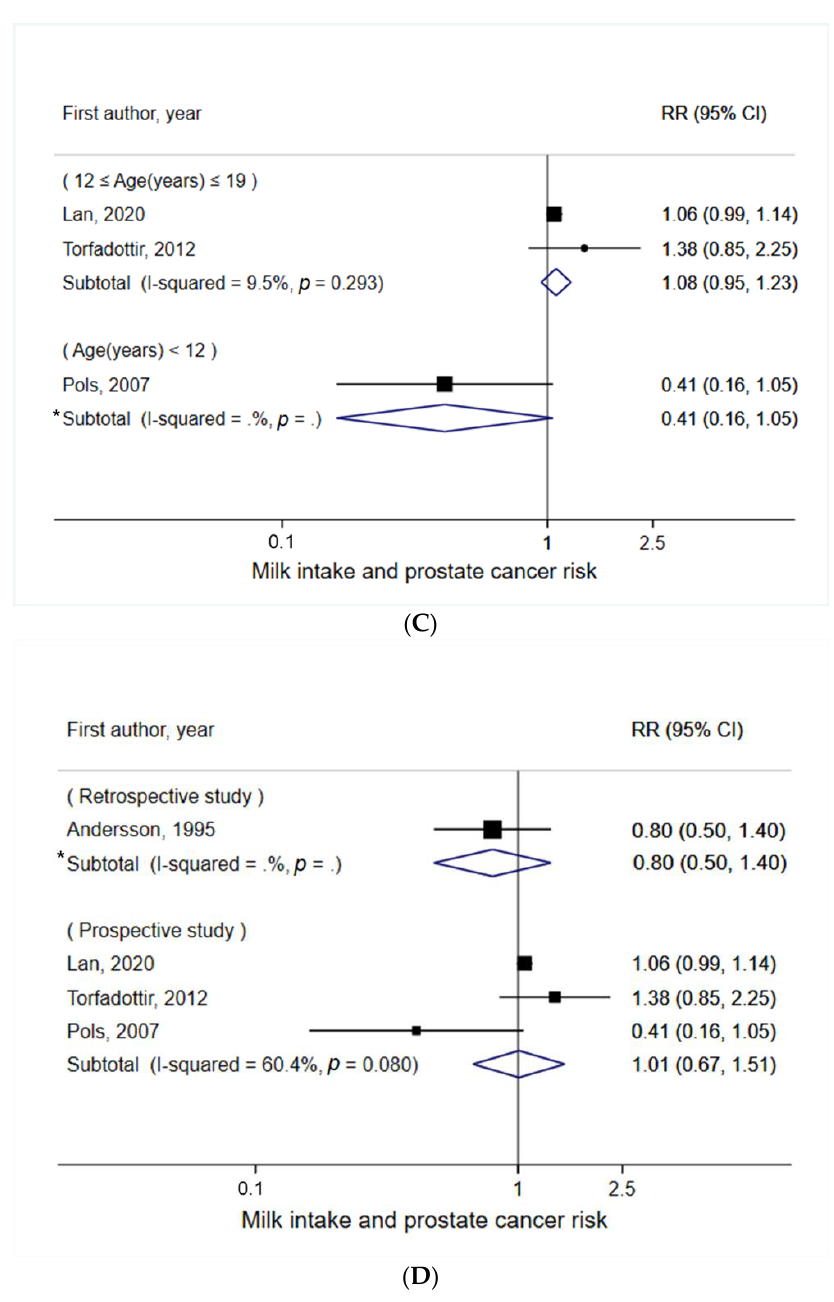
Figure 3. Meta-analysis of milk intake in early life ( A ) with any prostate cancer risk, ( B ) by cancer stage, ( C ) by life stage of milk intake, and ( D ) by study design. For each study, the RR and corre- sponding 95% CI of individual studies are marked by the location of the black box and the width of the horizontal line, respectively. The size of the box indicates the weight that the RR receives when calculating the summary estimate. The summary RR and its 95% CI are represented by the center and weight of the diamond, respectively. * I 2 and p value are not defined when there is only one study in the meta-analysis.